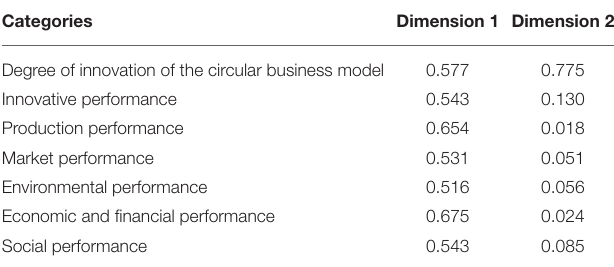
TABLE 3 | Variables and indicators of correspondence analysis. Variables